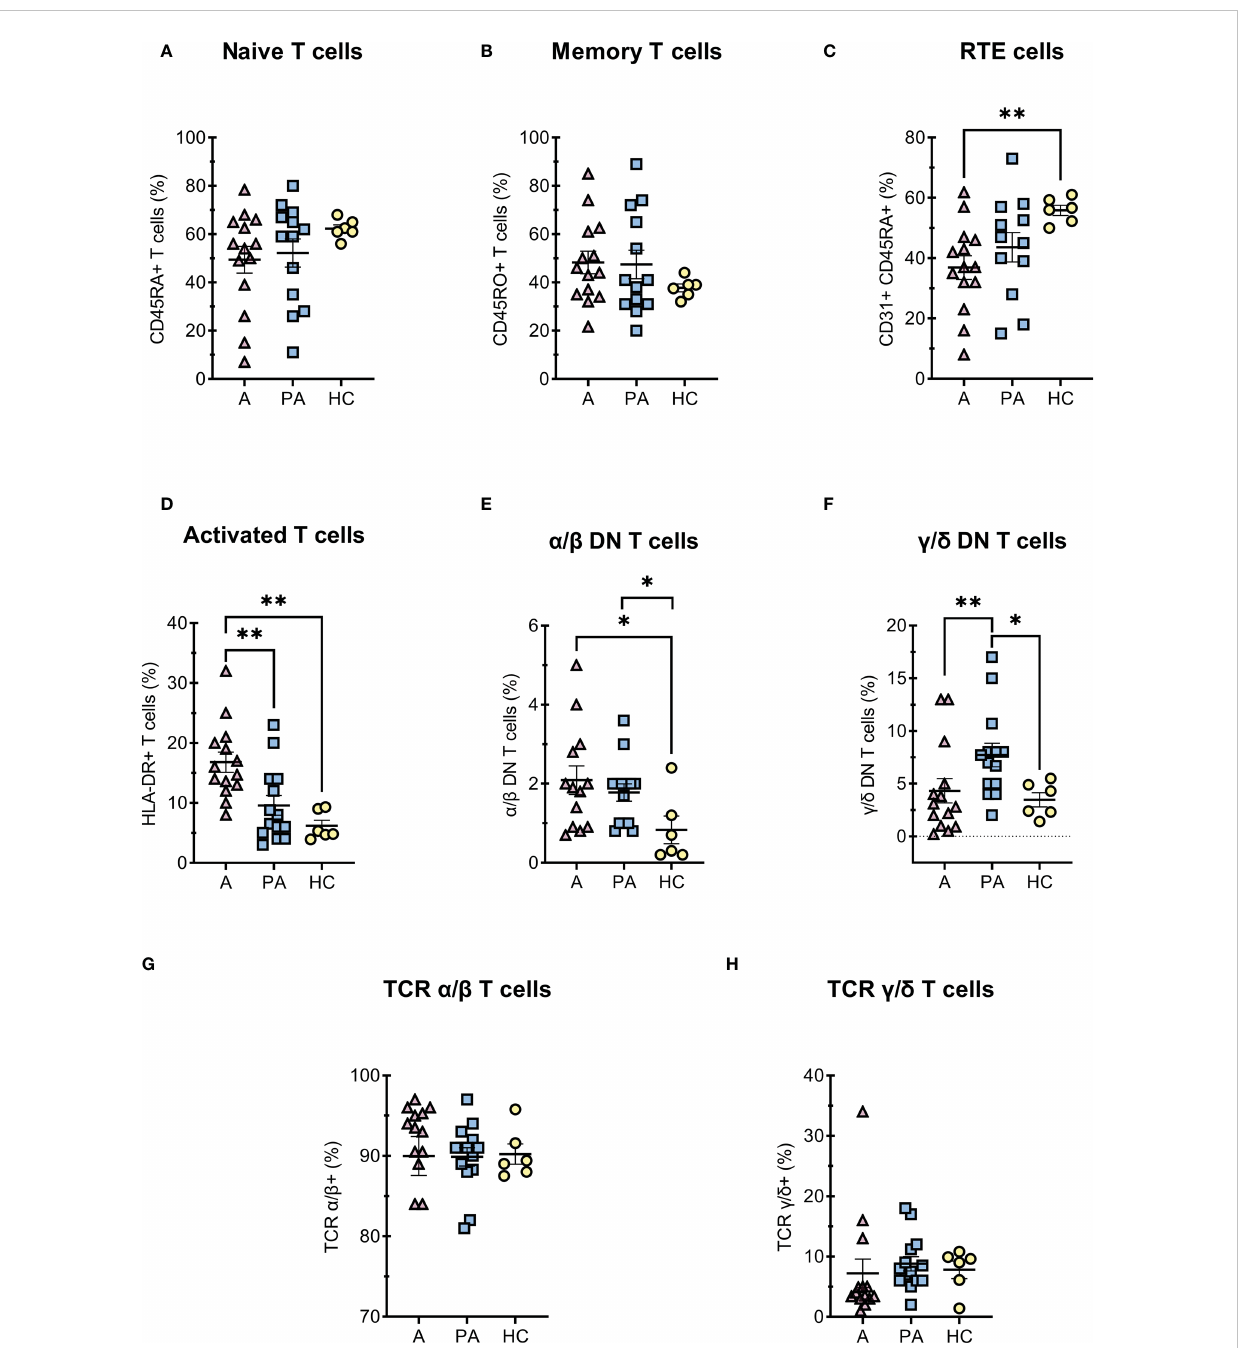
FIGURE 2 T cells diferentiation in MIS-C patients during acute and convalescent phase compared to age-matched HC. A-C, (percentages of CD4+ T cells) (A) naive CD45RA+ CD4+ T cells, (B) memory CD45RO+ CD4+ T cells, (C) RTE - recent thymic emigrants CD31+CD45RA+ CD4+ T cells; (D) (percentages of CD3+ T cells) activated HLA-DR+ T cells; E-F (percentages of CD3+, CD4- and CD8- T cells) (E) DN T a / b , (F) DN T g / d ; G-H (percentages of CD3+ T cells) (G) a / b T cells and (H) g / d T cells. Pink and blue shading represents patients with MIS-C in acute (A, n = 12-14) or convalescent (PA, n = 13-14) phase of the illness. Yellow shading represents healthy controls (HC, n = 6). Data are presented as means ± SEM. The Shapiro-Wilk normality test was used to test for the normal distribution. Signi fi cance testing between patients by phase of illness (A – acute, PA – convalescent) was performed using paired t-test for normal distribution or Wilcoxon test otherwise. For comparison between patient groups and HC, *P ≤ 0.05 and **P ≤ 0.01 were determined by un-paired t-test if the distribution was normal and Mann-Whitney test